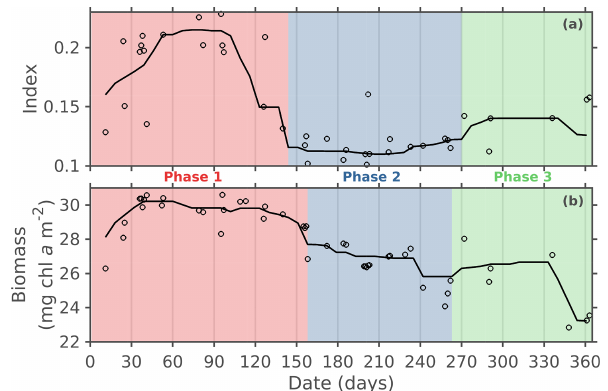
Figure 7. Seasonal cycle of the 2008 (a) normalised difference vegetation index (NDVI) and (b) simulated daily maximum of the MPB biomass (mgChl a m − 2 ) in the biofilm. Original extracted data (black circles) are overlaid. The black full lines represent the original extracted data regularised and filtered with running medi- ans (window size = 7). The NDVI was calculated at the pixel cor- responding to the study site. Phases were determined according to the amplitude of the sign change of the second-order